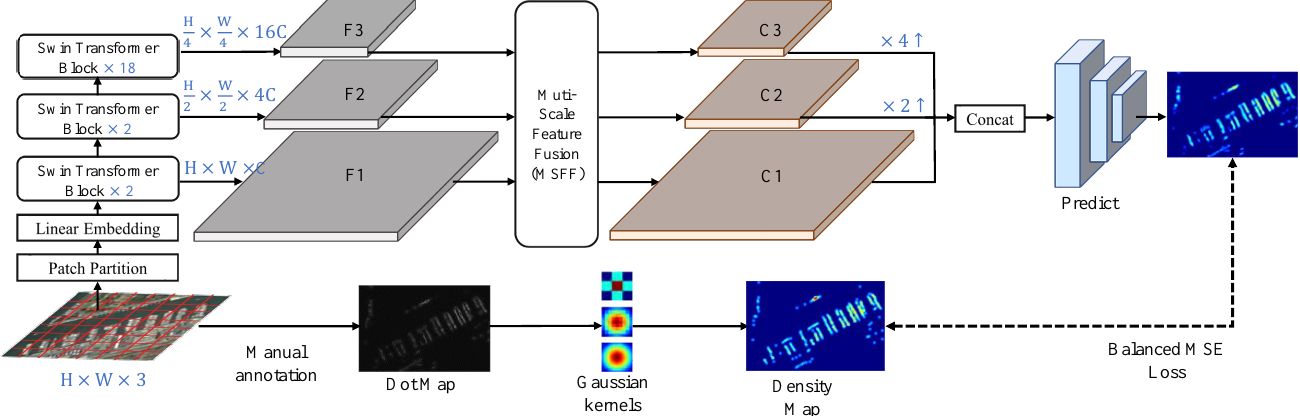
Figure 2. Pipeline of proposed proposed remote sensing object counting framework (SwinCounter). Firstly, Swin Transformer is used to extract multi-scale feature and send it into MSFF module to fuse multi-scale information. Finally, the fused feature information is used to predict density